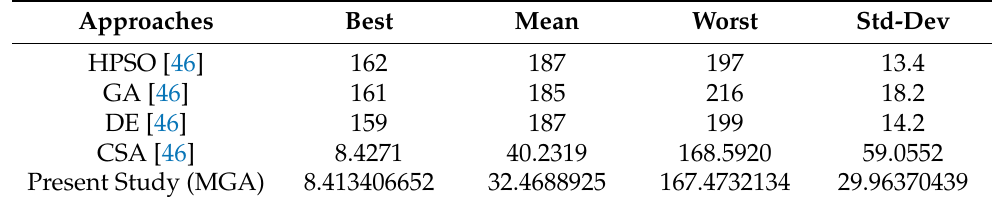
Table 26. Statistical results of different approaches for the piston lever design